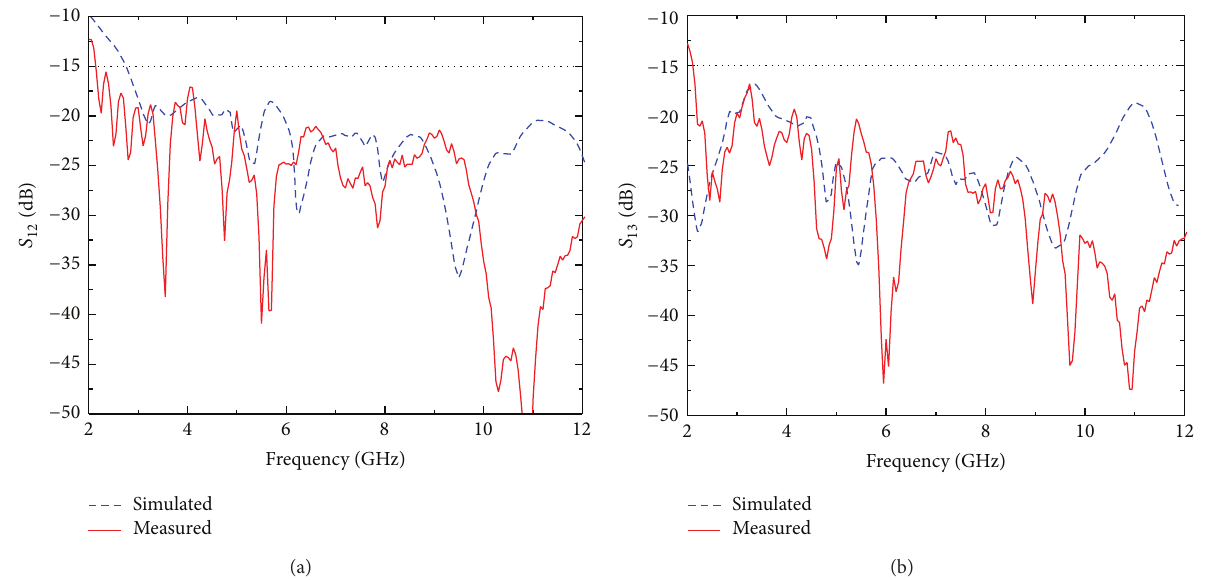
Figure 21: Simulated and measured results of mutual coupling of the final MIMO antenna: (a) cross-polarization elements and (b) copolarization elements.